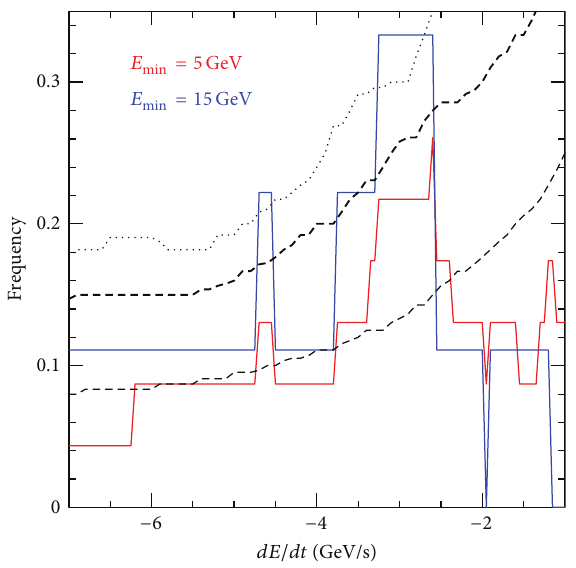
Figure 5: Here shown is a study of the frequency of occurrence of spectral lags in our sample as a function of a minimum photon energy and without any prior assumption on high energy photons. The red (resp., blue) solid line describes the frequency of occurrence of a certain spectral-lag slope within the sample of GRB130427A events with energy grater than 5 GeV (resp., 15GeV). Dotted/dashed lines represent the 10 %, 1 %, and 0.23 % probability that the given frequency of occurrence of spectral lags is a chance occurrence. The peak of the 𝑑𝐸/𝑑𝑡 distribution is consistent with the estimate of − 2.8 GeV/s obtained from the best-fit analysis described in Figure 4.